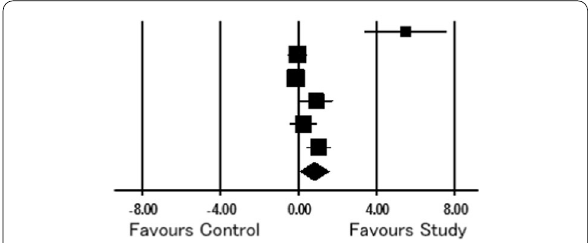
Fig. 3 Forest Plot ofthe effect of VR on gross motor coordination in children with CP